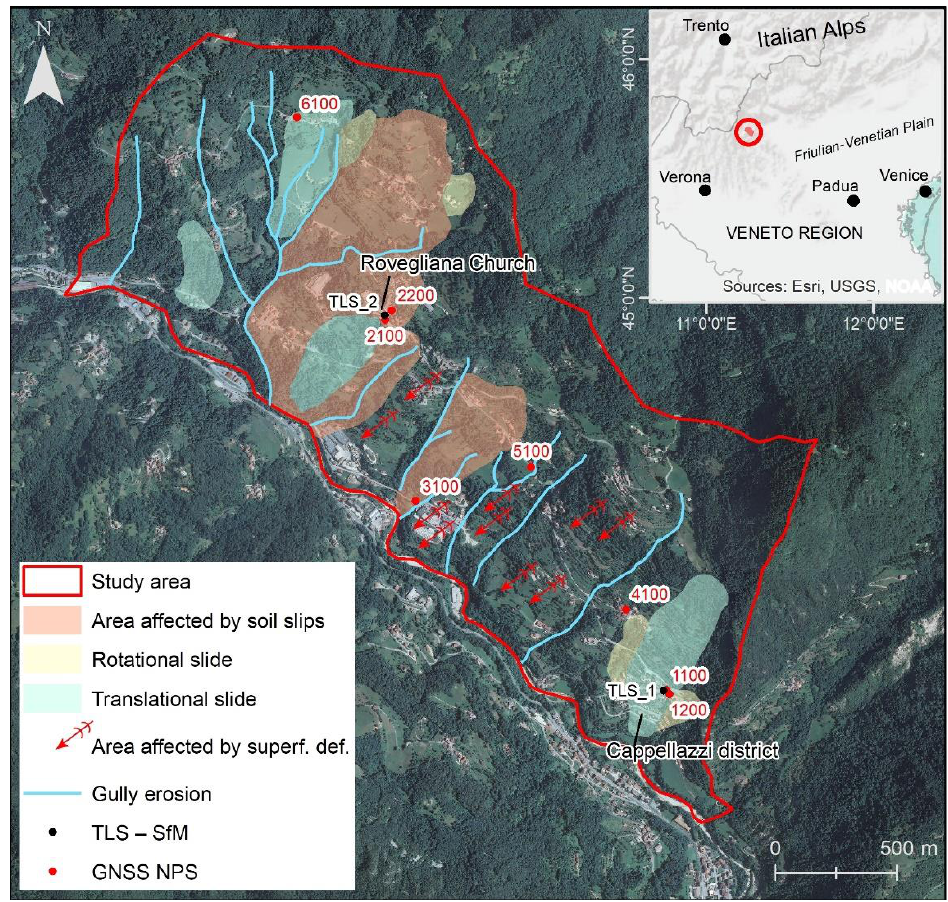
Figure 1. Location of the study area (inset) and map of the instability phenomena. Global navigation satellite system (GNSS) non-permanent stations (NPS) and the location of terrestrial laser scanning and structure for motion surveys (TLS–SfM) are shown.